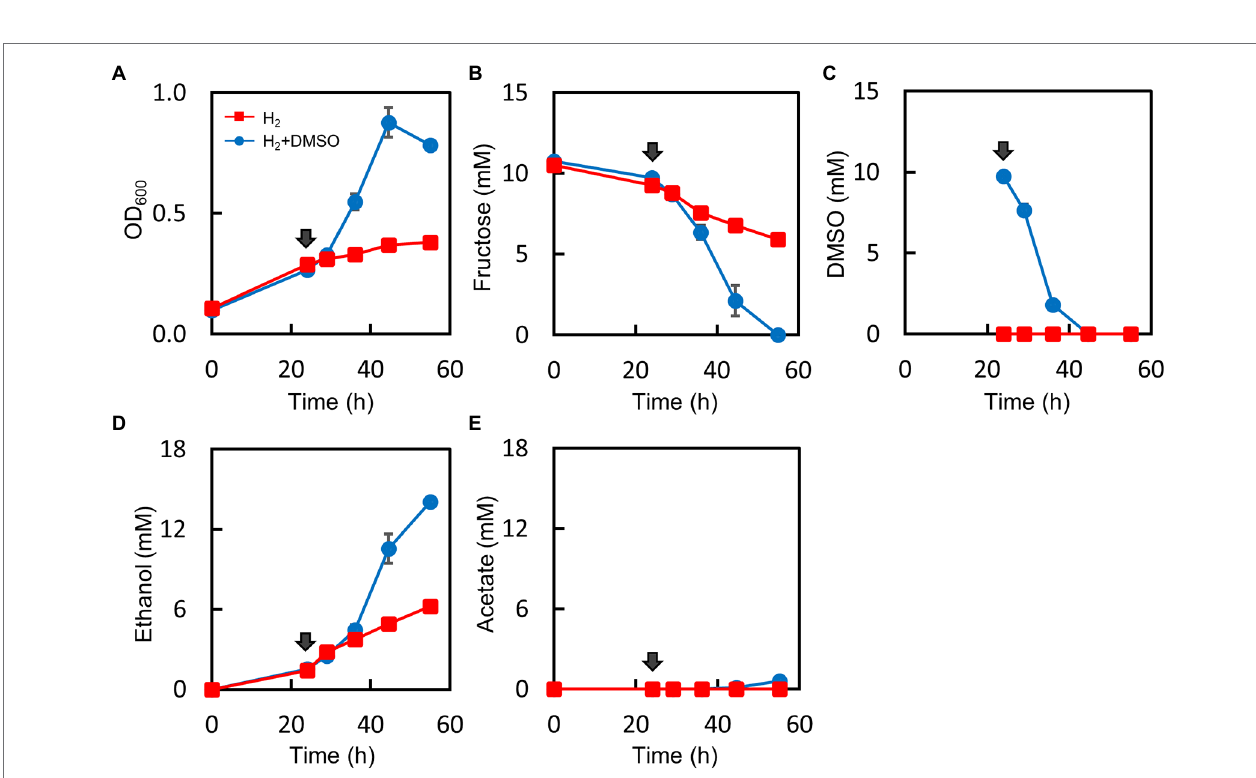
FIGURE 5 | Effect of DMSO supplementation on the culture profile in the H 2 -supplemented mixotrophic condition of the Mt- Δ pduL1 Δ pduL2 :: aldh strain. H 2 (0.08 MPa) was supplied to the fructose-supplemented culture, and DMSO (10 mM) was added to one group of the culture medium after 24 h (shown by arrows). The DMSO-supplied condition is shown in blue, whereas the no-DMSO condition is shown in red. Each graph shows the culture profiles for (A) , OD 600 ; (B) , Fructose concentration; (C) , DMSO concentration; (D) , Ethanol production; (E) , Acetate production. Error bars represent the SD of three biological